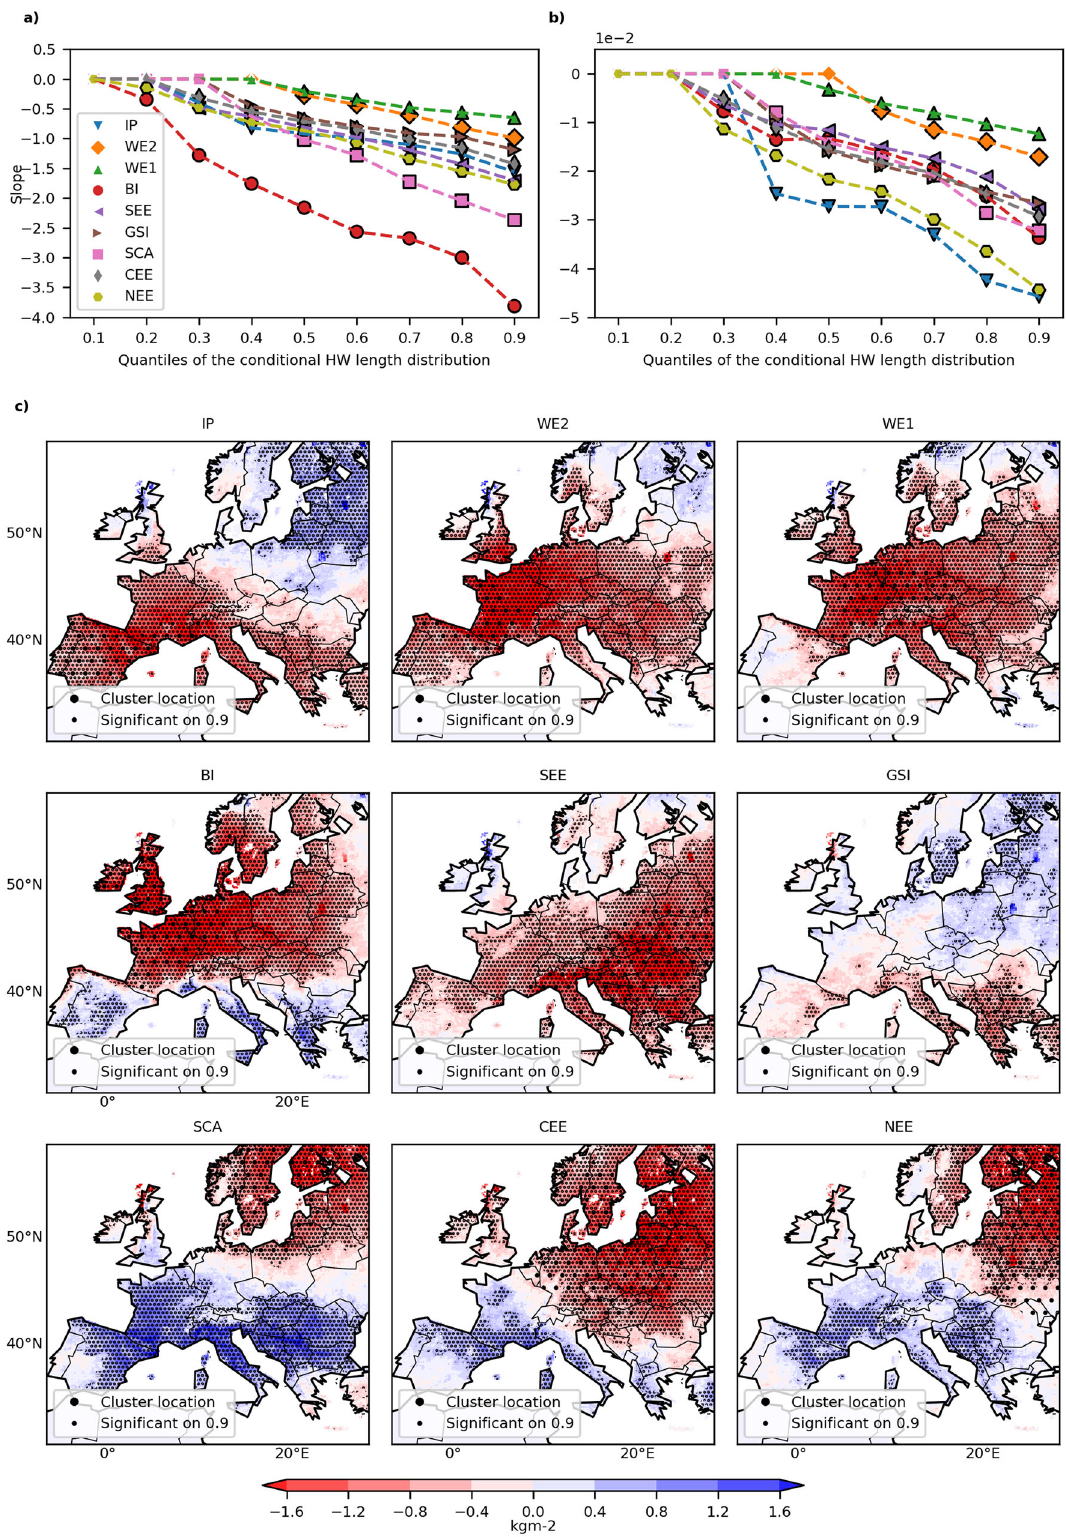
Fig. 5 Quantile regression slopes for N HW in relation to moisture-related variables in summer. N HW versus mrsos MJAAS ( a ) and pr MJJAS ( b ). Statistically signi fi cant slopes with a 90% con fi dence level with a two-sided t -test are identi fi ed with the black edge. mrsos MJJAS for 25 years with the highest number of heatwave days in ( c